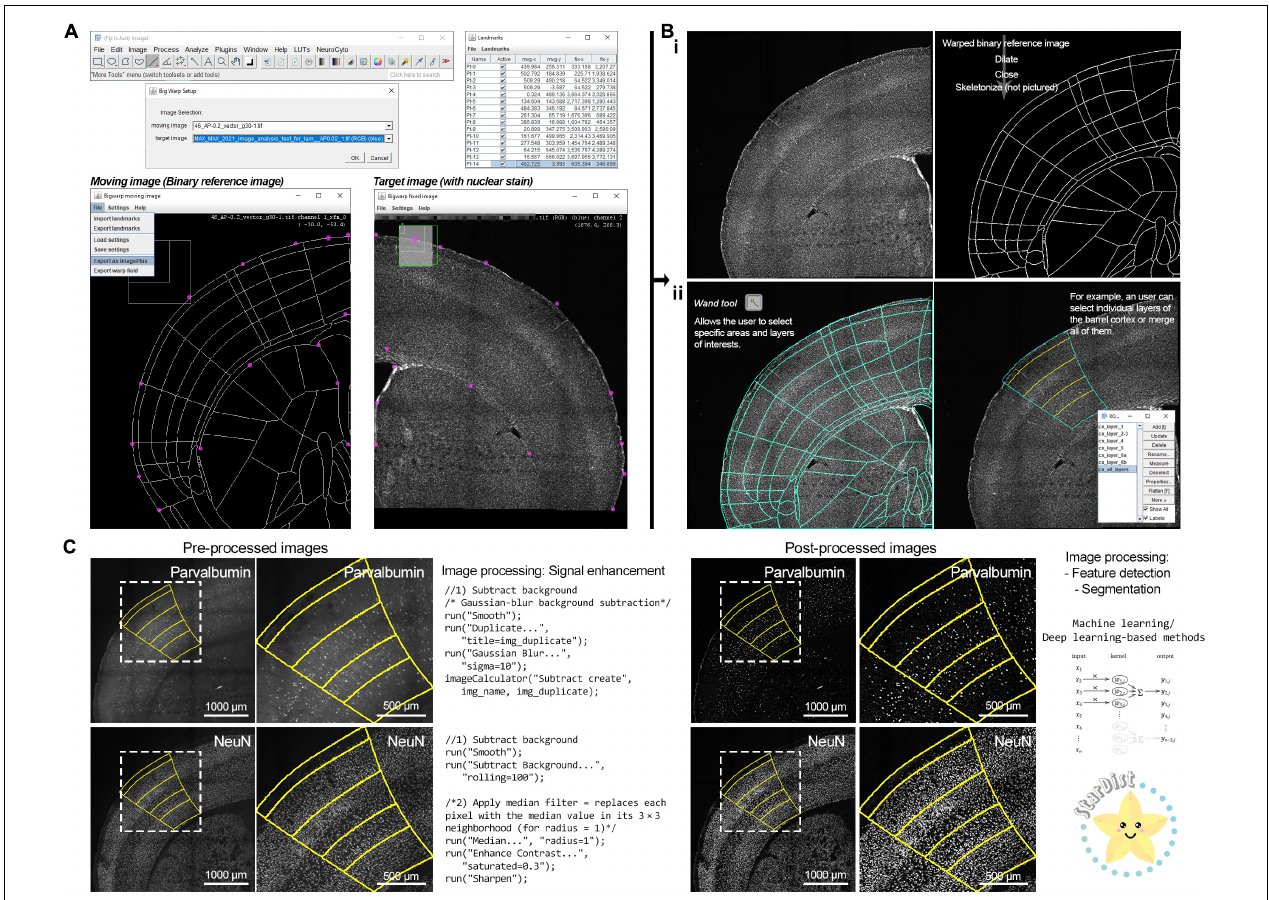
FIGURE 2 | A FIJI-ImageJ based workflow for registration and image processing of mouse brain sections. (A) Brain section images can be registered to a unified atlas using the FIJI-Image-J plugin “ Big Warp .” Using a nuclear stain (such as Hoechst) facilitates the placement of anatomical landmarks to adjust the